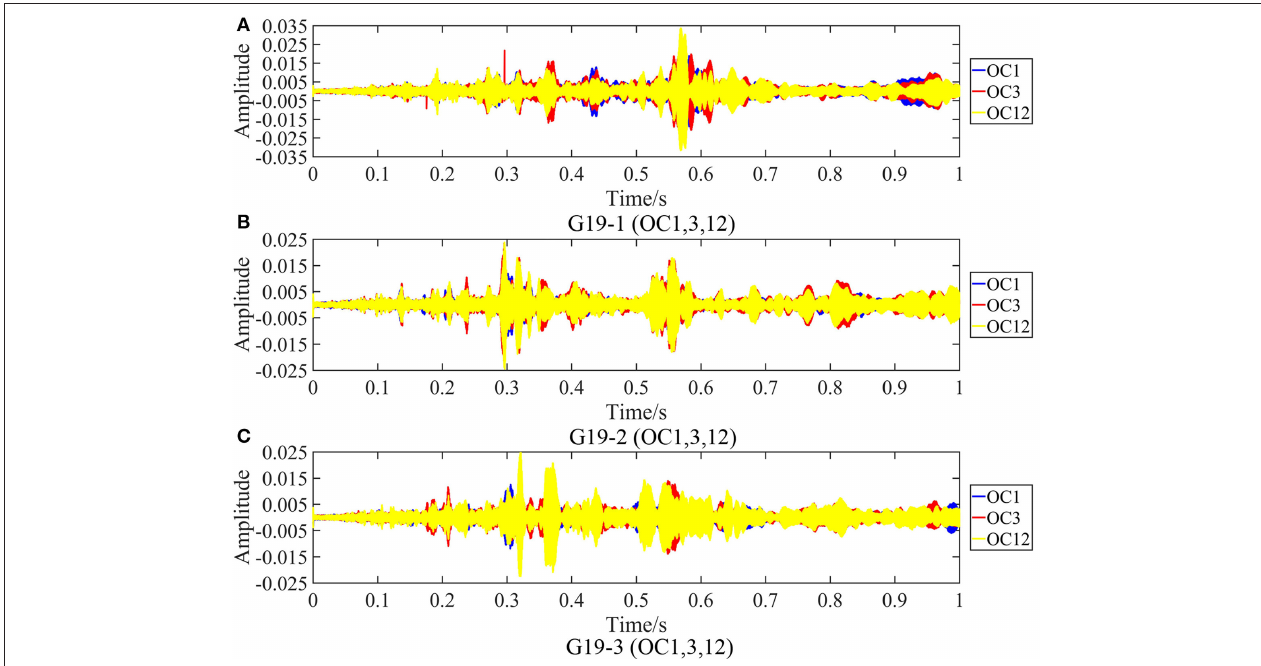
FIGURE 9 | Time domain of G16 after testing under different operating conditions. (A) Time domain of G19-1 under different operating conditions. (B) Time domain of G19-2 under different operating conditions. (C) Time domain of G19-3 under different operating conditions.